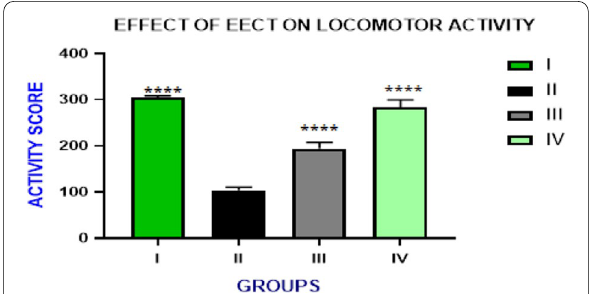
Fig. 2 Effect of EECT on Locomotor Activity